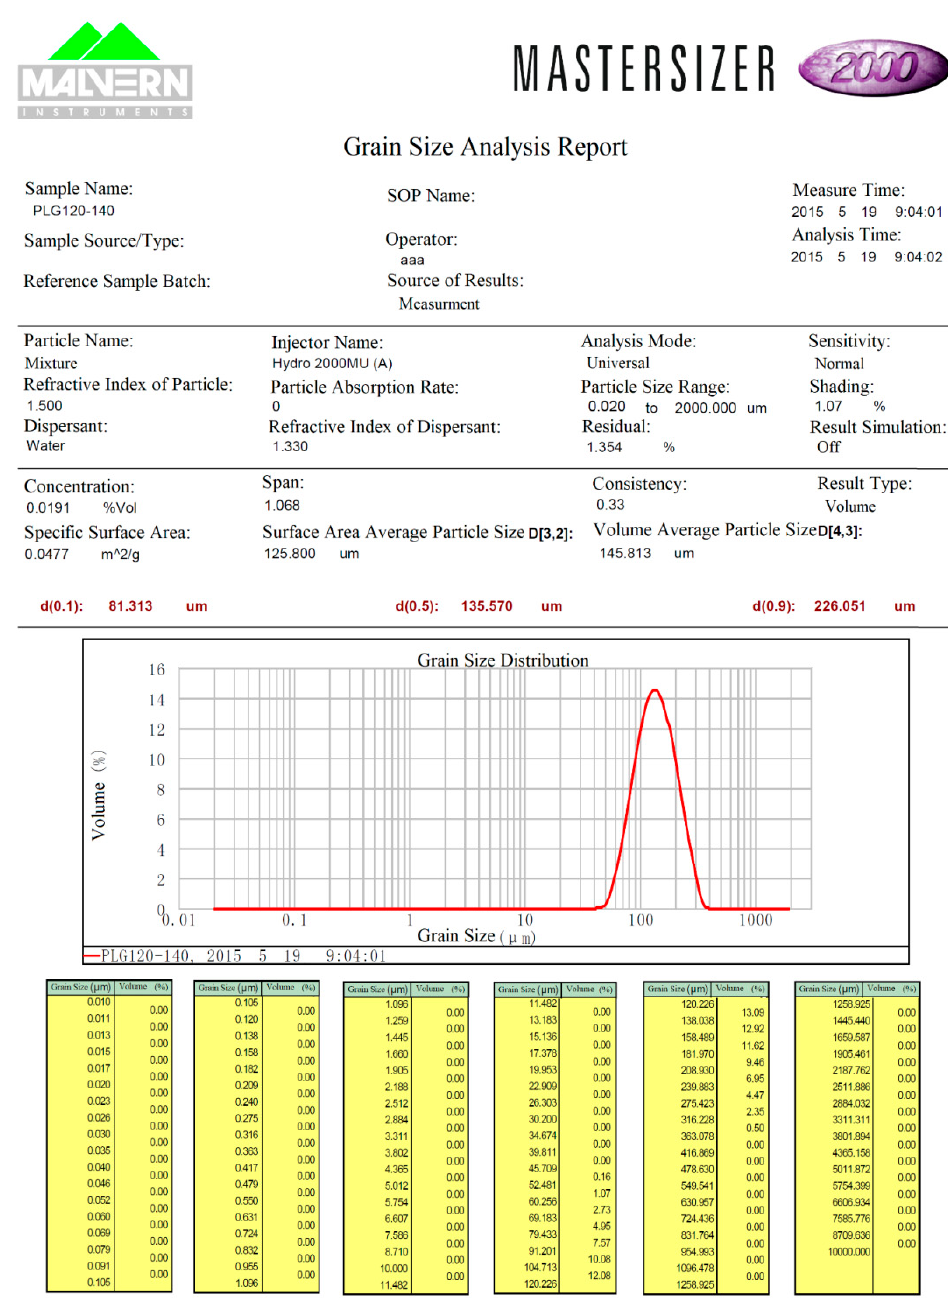
Figure 3. The grain size analysis report of plagioclase.